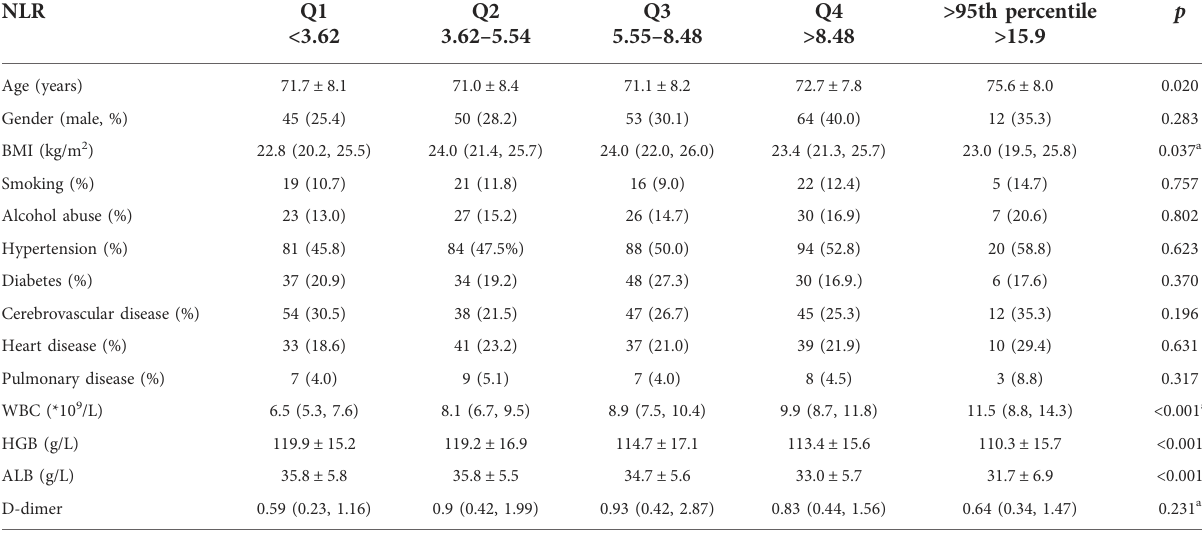
TABLE 1 Comparisons of baseline characteristics of included patients across fi ve subgroups of